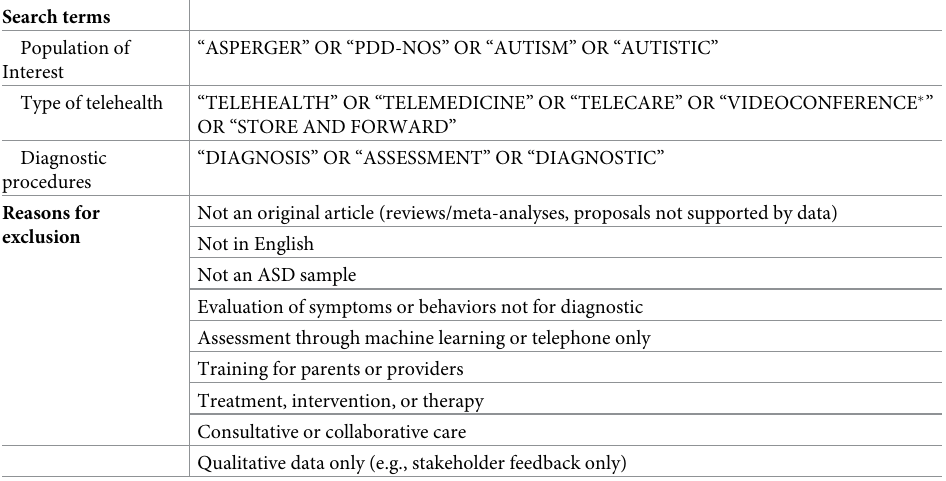
Table 1. Search terms and reasons for